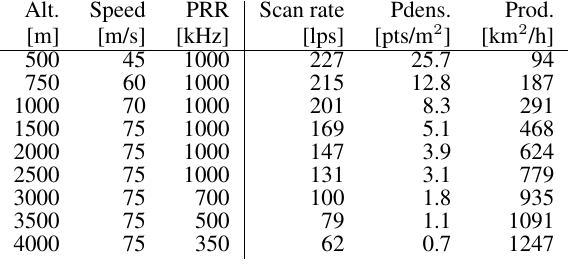
Table 2. Scan rates to produce a uniform point pattern for different settings of altitude above ground level (Alt.), flight speed and pulse repetition rate (PRR). Furthermore, resulting point densities (Pdens.) and laser scanning productivity (Prod.) assuming horizontal terrain and no overlap between adjacent flight strips were calculated for the different settings used in the VLS